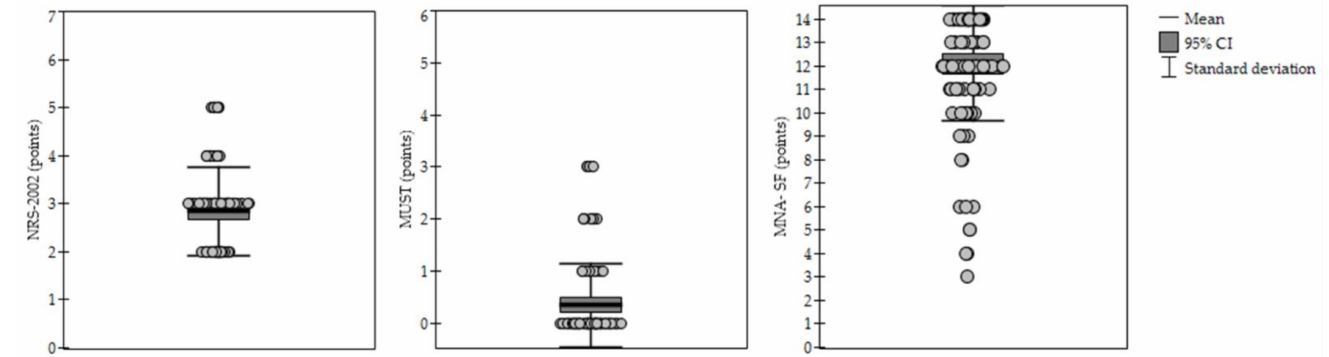
Figure 2. The distribution of scores for the screening questionnaires. Notes: NRS-2002, Nutritional Risk Score; MUST, Malnutrition Universal Screening Tool; MNA-SF, Mini Nutritional Assessment— Short Form.